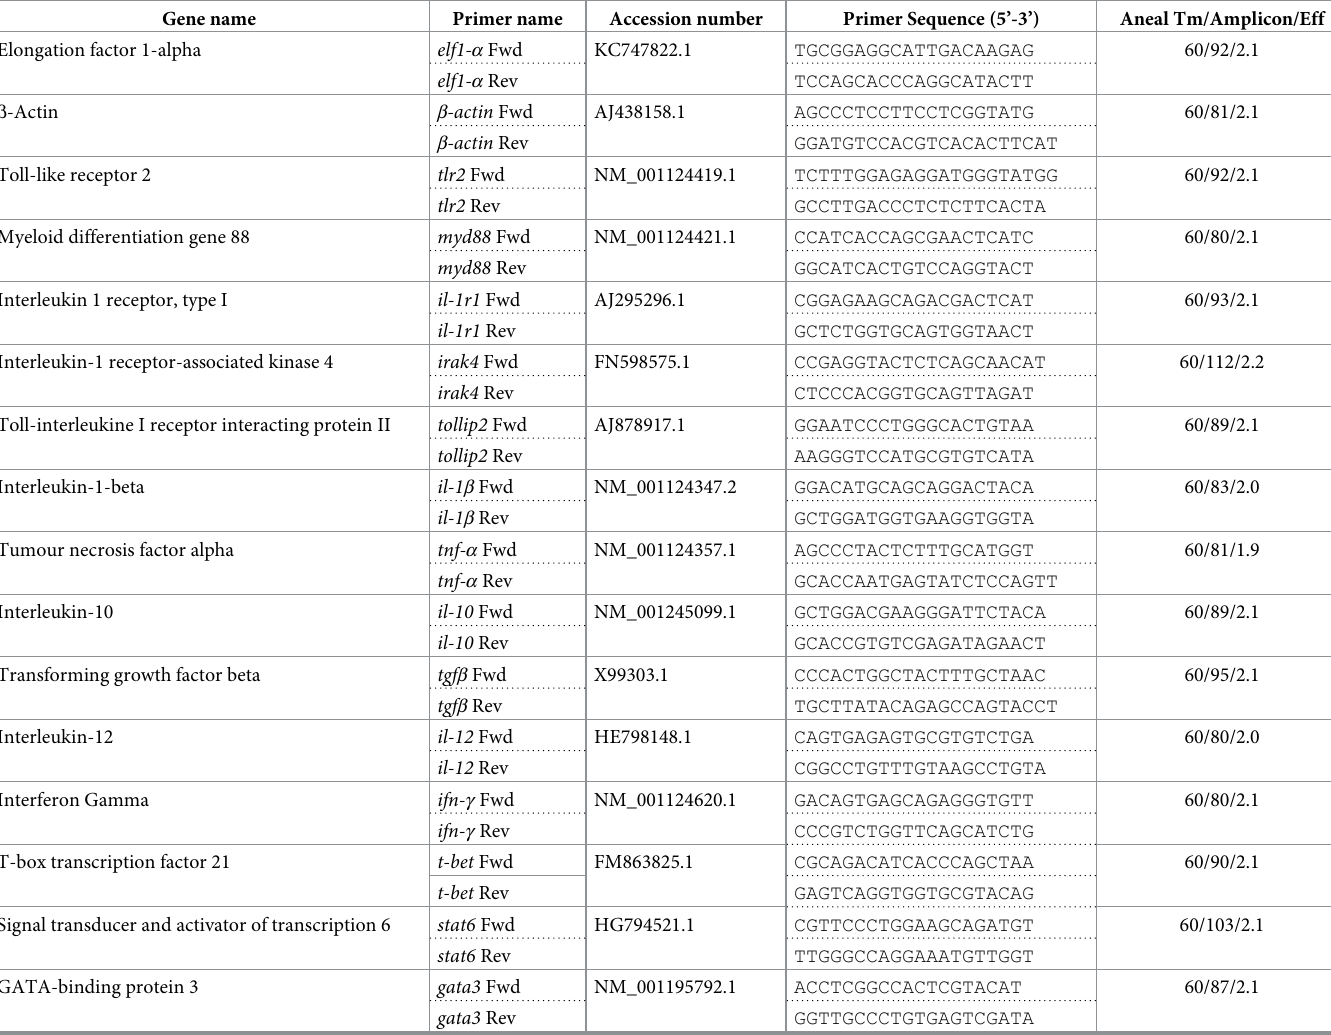
Table 2. Primer pair sequences, gene name abbreviations, annealing temperature (Aneal Tm in˚C), amplicon size (bp) and primer efficiency (Eff) for genes used for real-time